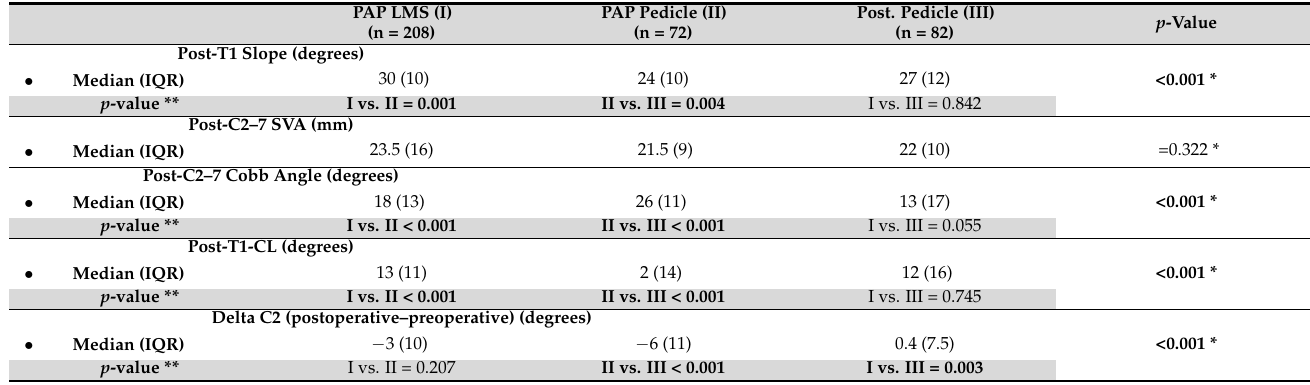
Table 3. Cervical lordosis parameters in the studied groups—continuation.